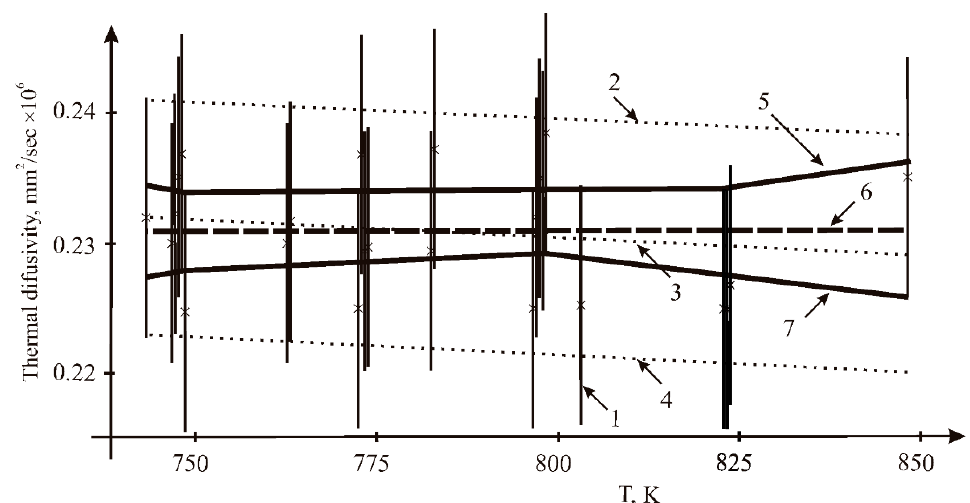
Figure 3. Thermal diffusivity data for FLiNaK: Our result ( ⯁ ), Kato ( ■ ), Robertson ( ▲ ). Our data were fitted by two mathematical methods: least square (LSQM) and interval analysis. From the results shown in Figure 4, it can be seen that our results manifest no significant temperature dependence. The bound on the maximum value of the measure- ment error was equal to 0.0091 mm 2 /s.